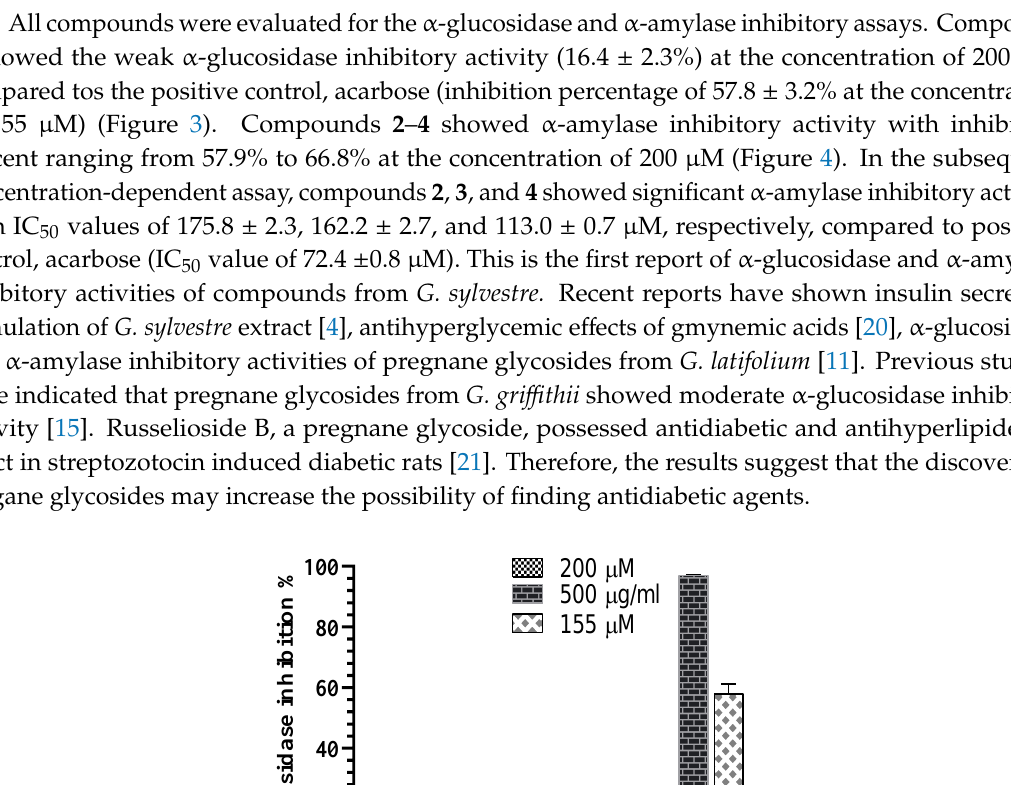
Figure 4. α -Amylase inhibitory effects of the G. sylvestre extract and compounds 1 – 9 . 3. Materials and Methods 3.1. General All NMR spectra were recorded on an Agilent 400-MR-NMR (Agilent technologies, Santa Clara, CA, USA) spectrometer operated at 400 and 100 MHz for hydrogen and carbon, respectively. Data processing was carried out with the MestReNova ver.6.0.2 program. HRESIMS spectra were obtained using an AGILENT 6550 iFunnel Q-TOF LC/MS system (Agilent technologies, Santa Clara, CA, USA). Optical rotations were determined on a Jasco DIP-370 automatic polarimeter. Preparative HPLC was carried out using an AGILENT 1200 HPLC system. Column chromatography was performed on silica-gel (Kieselgel 60, 70 – 230 mesh and 230 – 400 mesh, Merck) or YMC RP-18 resins (30 – 50 µm, Fuji Silysia Chemical Ltd., Aichi, Japan). For thin layer chromatography (TLC), a pre-coated silica-gel 60 F254 (0.25 mm, Merck, Darmstadt, Germany) and RP-18 F254S plates (0.25 mm, Merck, Darmstadt, Germany) were used. 3.2. Plant Material The leaves of Gymnema sylvestre (Retz.) R.Br. ex Sm. were collected in Hai Loc, Hai Hau, Nam Dinh in November, 2015, and identified by Dr. Nguyen The Cuong, Institute of Ecology and